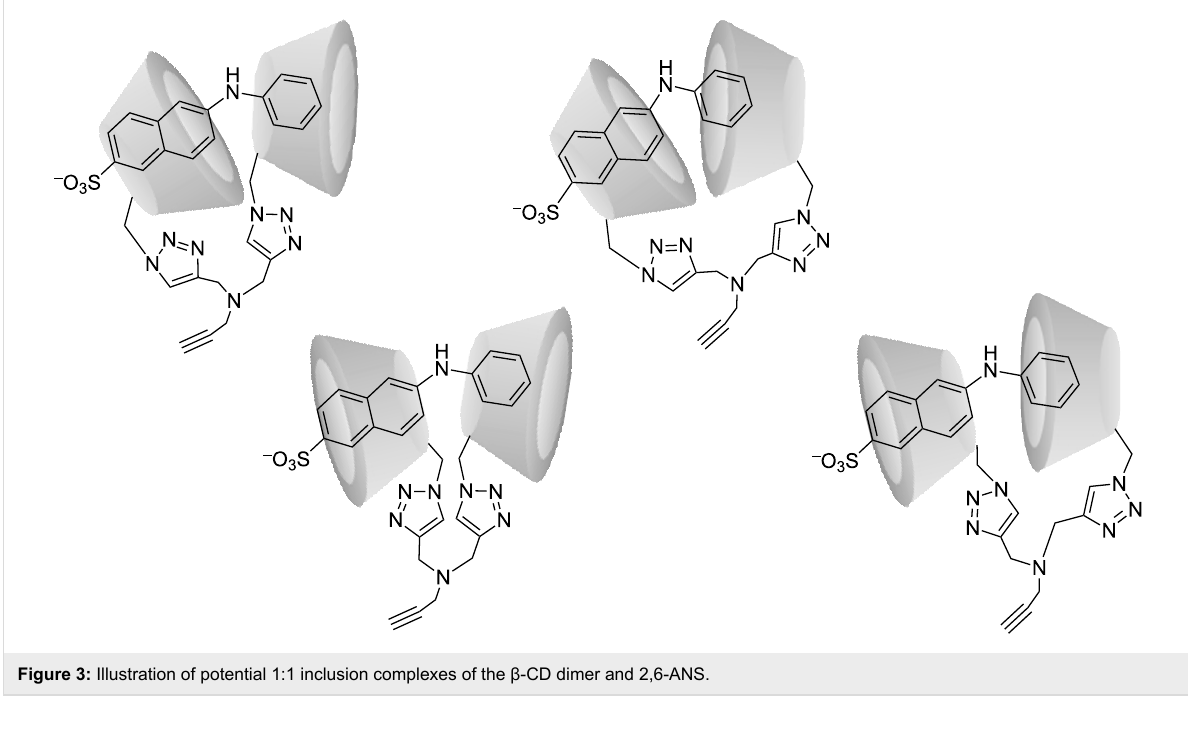
Figure 3: Illustration of potential 1:1 inclusion complexes of the β -CD dimer and 2,6-ANS.